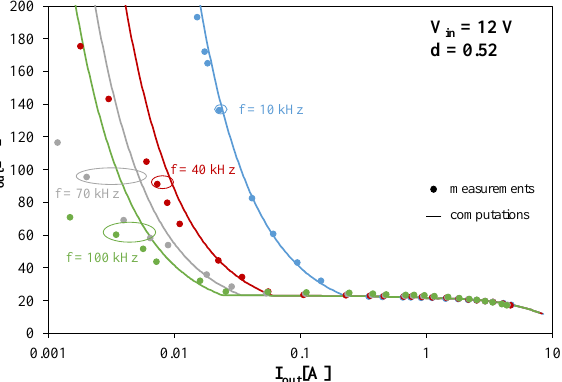
Figure 7. Measured and computed output characteristics of the boost converter for the transistor and the diode placed on heat sinks for selected values of switching frequency.